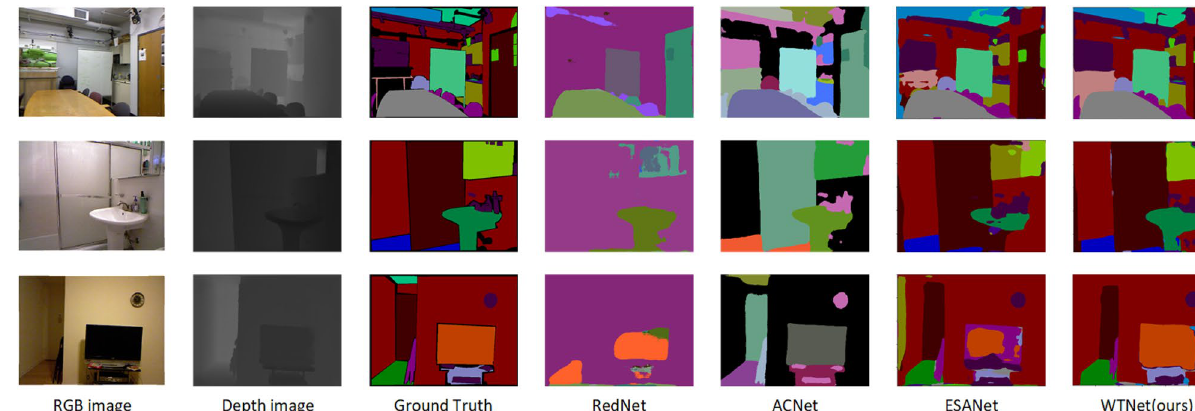
Figure 9. Result of segmentation.